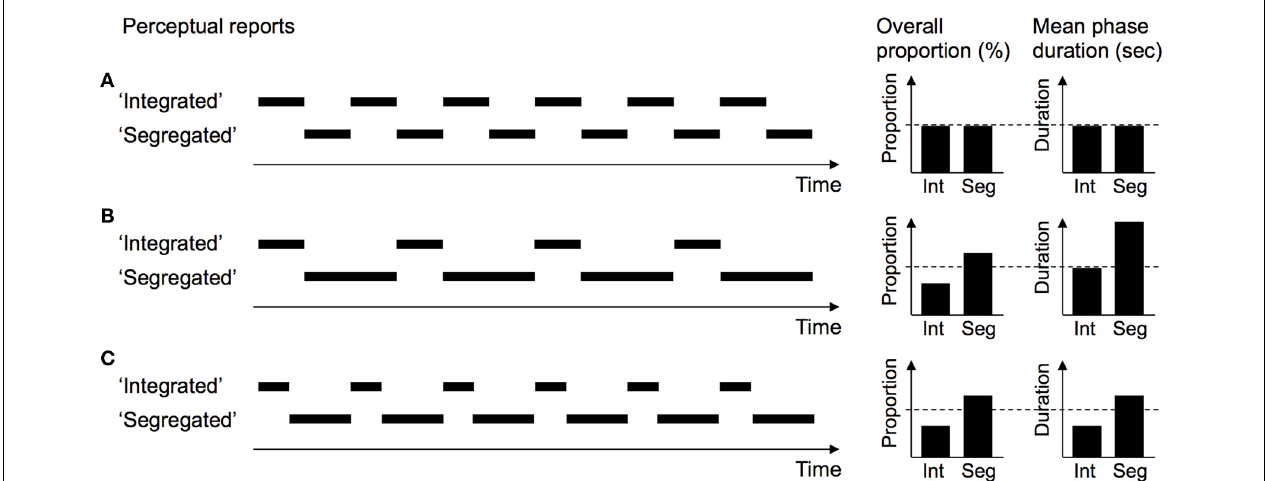
FIGURE 4 | Possible cue effects in the subjective-report procedure. Artificially simplified time-courses of perceptual switching were generated for illustration purposes. The upper row (A) reflects a balanced distribution of “Integrated” and “Segregated” percepts. The middle row (B) shows the impact of a percept-stabilizing cue in favor of stream segregation, which prolongs the duration (i.e., stability) of “Segregated” percepts but leaves the duration of “Integrated” percepts unaffected. The lower row (C) shows the impact of a percept-inducing cue in favor of segregation, which prolongs the duration of “Segregated” percepts and additionally shortens the duration of